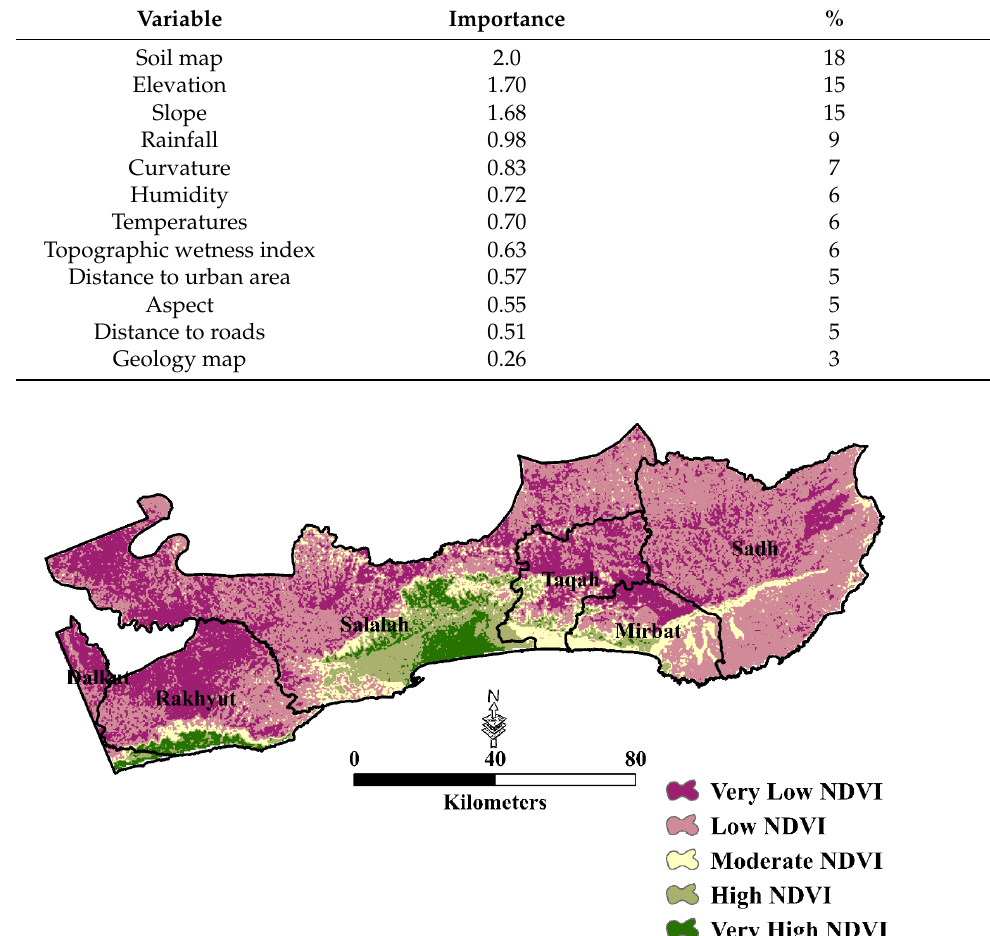
Figure 11. The best areas for vegetation based on the FBCR model.